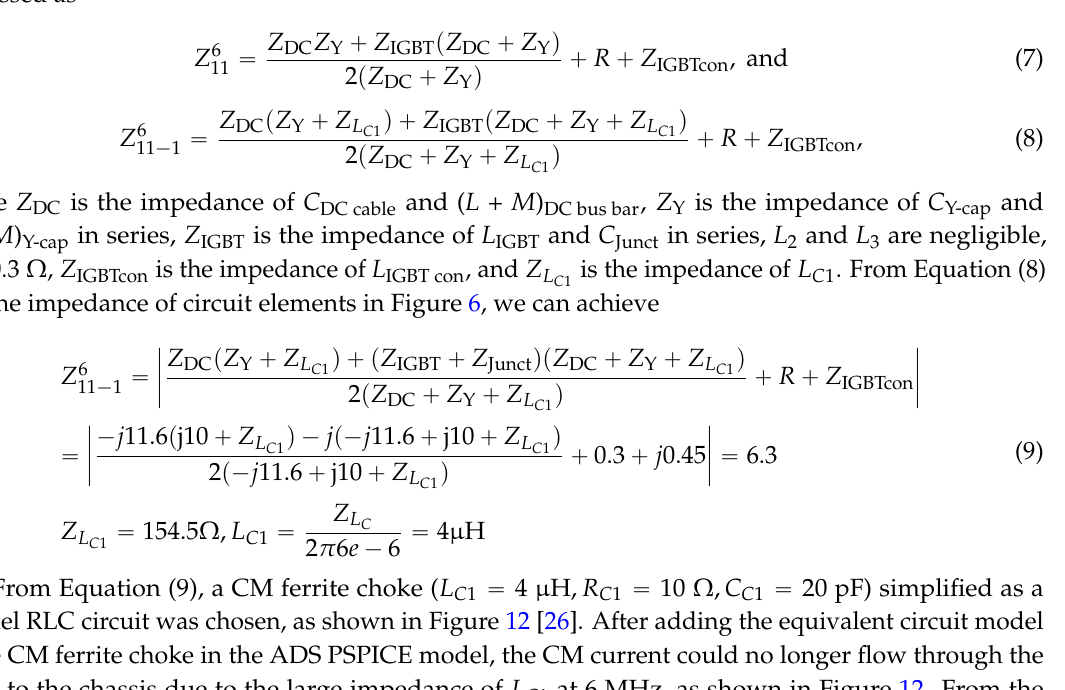
Figure 11. Current source equivalent circuit.